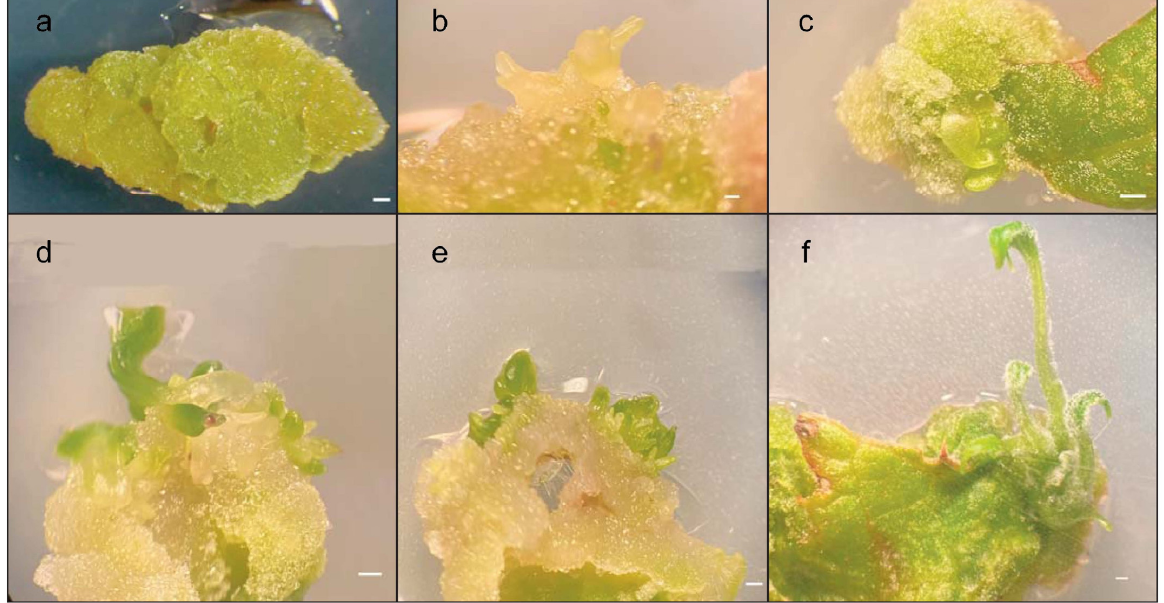
Figure 2. In vitro callus regeneration produced by leaves of Adenostyles alpina subsp. macrocephala . ( a ) The callus that developed in the medium when the NAA was replaced with 2.4 D. ( b – f ) Different stages of indirect organogenesis in the MS medium integrated with 3 mg L ⁻ ¹ BAP and 1 mg L ⁻ ¹ NAA. Bars ( a – f ) = 1 mm. The mean value of shoots per explant obtained was 3.21 for medium N2, 2.98 for medium N3, and 4.38 for medium N4 (Figure 3). An increase in the vigor of the shoots obtained is therefore observed in the medium with increasing concentrations of cytokinin (BAP) in combination with 1 mg L ⁻ ¹ NAA. The culture medium containing 3 mg L ⁻ ¹ BAP and 1 mg L ⁻ ¹ NAA gave the best results (Figure 4).